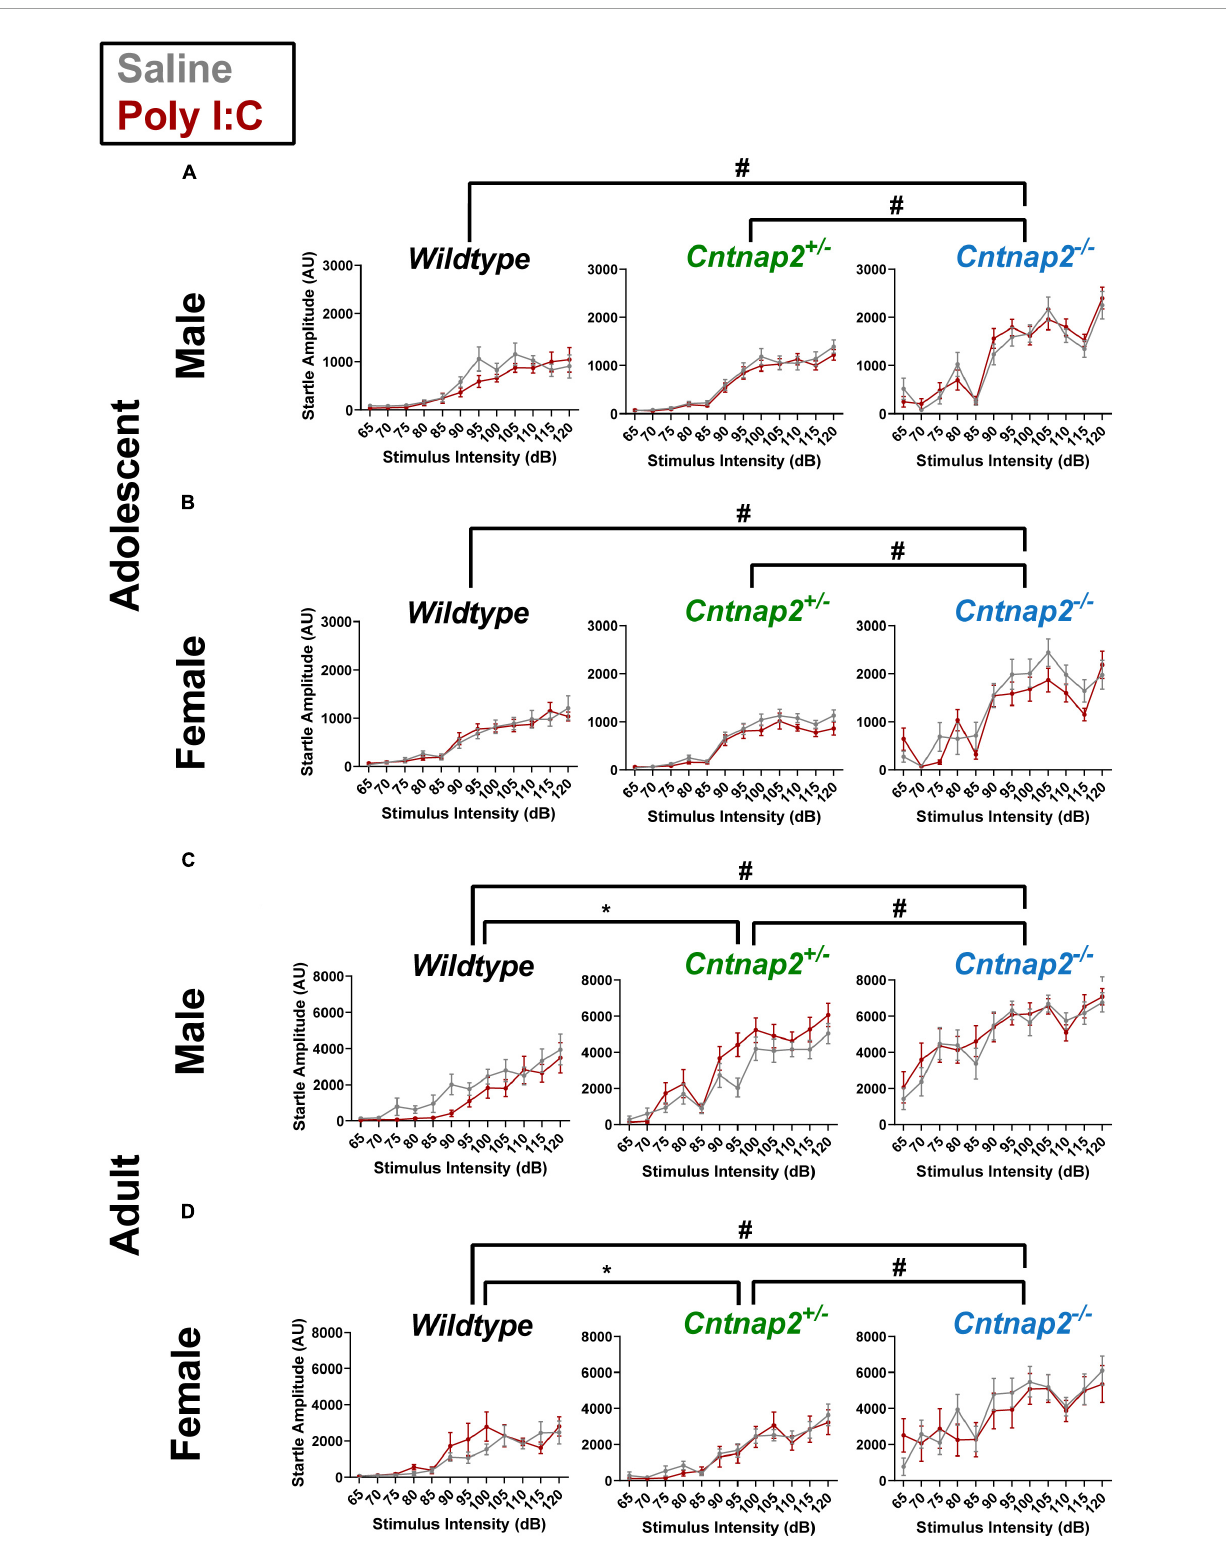
FIGURE3 Partial and full Cntnap2 knockout show age-dependent effects on startle reactivity. (A,B) Cntnap2 − / − adolescent animals show a general increase in startle reactivity compared to Cntnap2 + / − animals at all stimulus intensities except at 70 and 85 dB (adjusted # p < 0.05 for each stimulus intensity comparison). (C,D) In adulthood, Cntnap2 − / − offspring startled significantly higher than Cntnap2 + / − and WT offspring at all intensities ( # p < 0.05 for each stimulus intensity comparison), whereas Cntnap2 + / − offspring startled significantly higher than WT offspring at 100 dB or higher intensities (adjusted ∗ p < 0.05 for each stimulus intensity comparison). Data are shown as mean ± standard error. For information on sample sizes for each group, please see Table 1